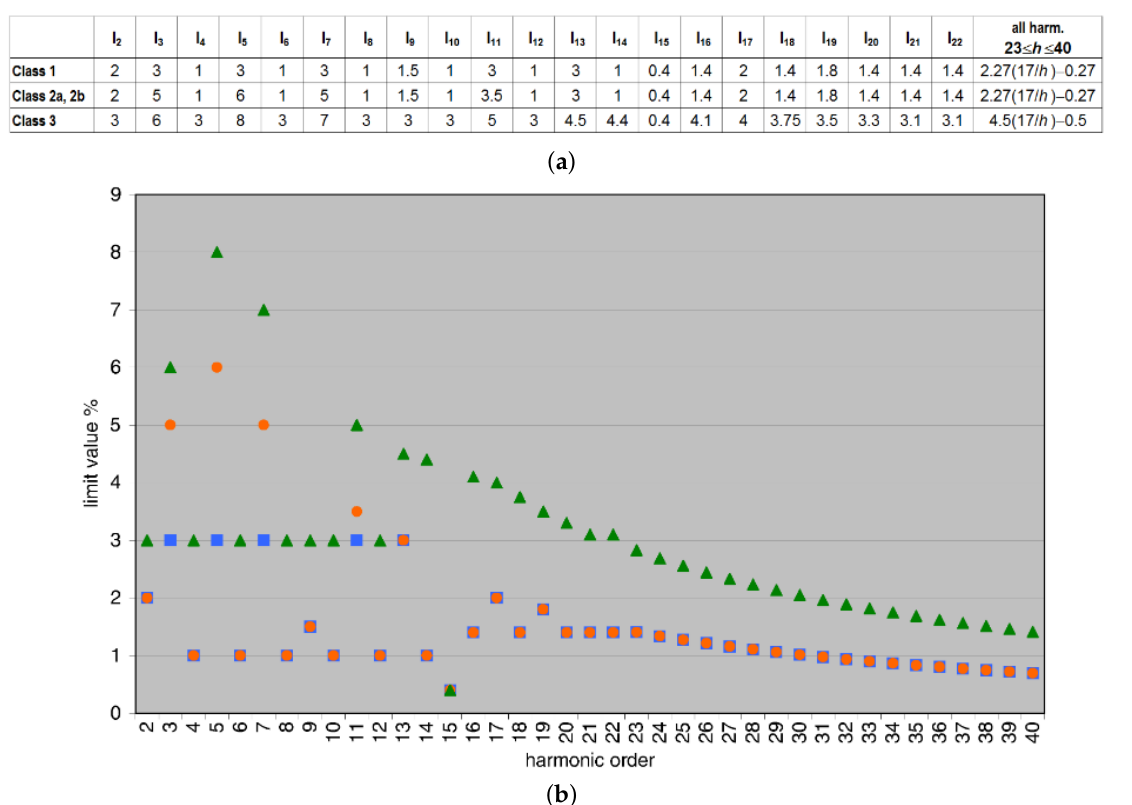
Figure 3. Harmonic distortion compatibility levels for light/heavy industrial networks (Table 2 of IEC 61000-2-4), with a prescribed voltage THD level of 11%: ( a ) numeric values, ( b ) graphical